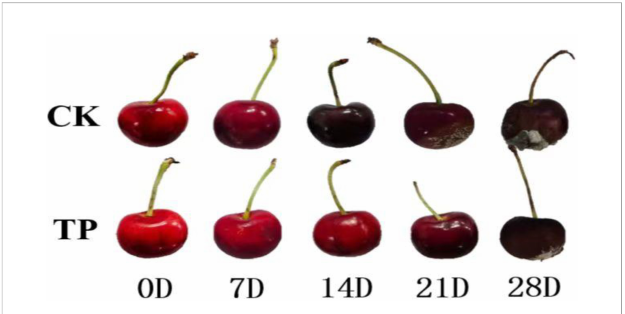
FIGURE 1 The visual appearance of different treatment cherry fruit stored for 28 days at